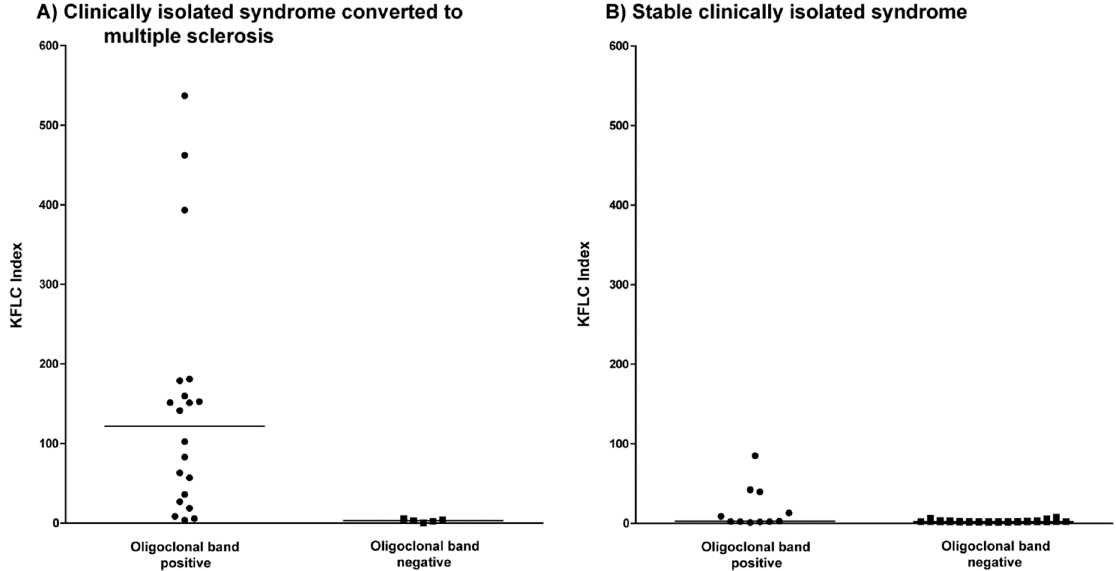
Figure 2. Kappa free light chain (KFLC) index in clinically isolated syndrome. ( A ) The KFLC index defined as (KFLC in CSF/KFLC in serum) divided by albumin quotient (albumin in CSF/albumin in serum) in patients with clinically isolated syndrome who converted to multiple sclerosis during follow-up compared between patients with positive (dots) and negative oligoclonal bands (squares). ( B ) The KFLC index in patients with stable clinically isolated syndrome compared between patients with positive (dots) and negative oligoclonal bands (squares).